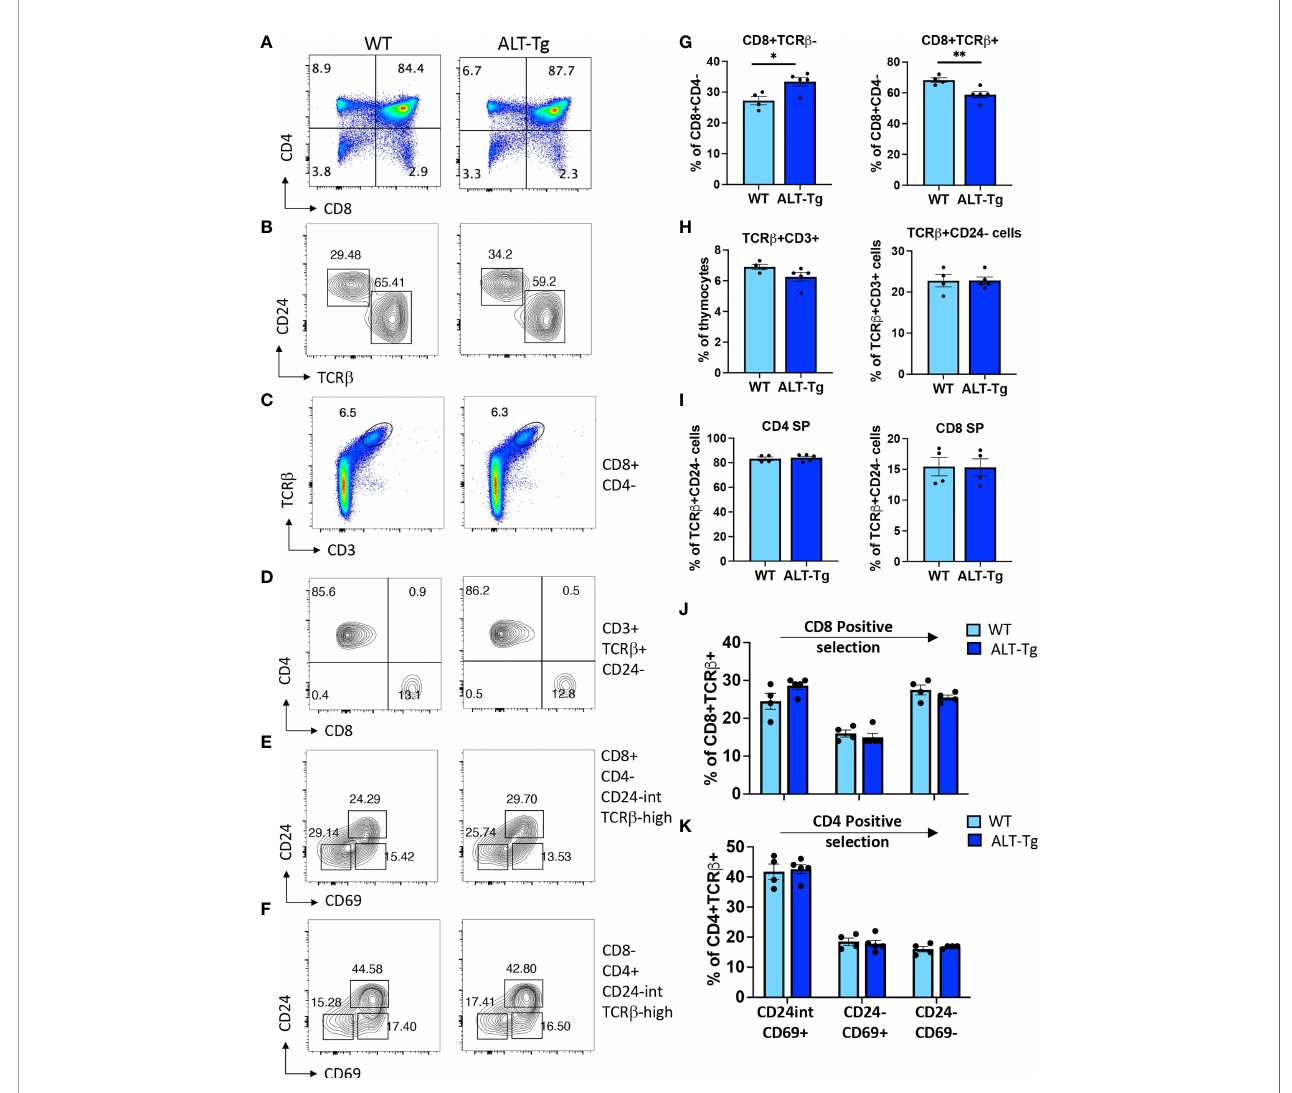
FIGURE 6 | Perturbation of the ISP to CD8 SP thymocyte ratio in ALT-Tg mice. (A) Flow cytometry plot showing the gates for CD4+ CD8- and CD4- CD8+ cells. (B) Flow cytometry plots showing immature (CD24-hi TCR b -) and mature (CD24-low TCR b +) subsets in the CD8+ subset gated as in (A) . (C) Flow cytometry plots showing the percentages of TCR b + CD3+ cells within the total thymocyte population. (D) Flow cytometry plot of the percentages of CD4 and CD8 cells within the TCR b + CD3+ CD24- population. (E) Flow cytometry plot of CD8+ TCR b + CD24- cells passing through each stage of positive selection as assessed by sequential downregulation of CD24 and CD69. (F) Flow cytometry plot of CD4+ TCR b + CD24- cells passing through each stage of positive selection as assessed by sequential downregulation of CD24 and CD69. (G) Quanti fi cation for replicates of the plots shown in (B) . (H) Quanti fi cation for replicates of the plots shown in (C) and for the percentages of CD24- cells within the TCR b + CD3+ population, which are not shown as FACS plots. (I) Quanti fi cation for replicates of the plots shown in (D) . (J) Quanti fi cation for replicates of the plots shown in (E) . (K) Quanti fi cation for replicates of the plots shown in (F) . *P < 0.05, **P <